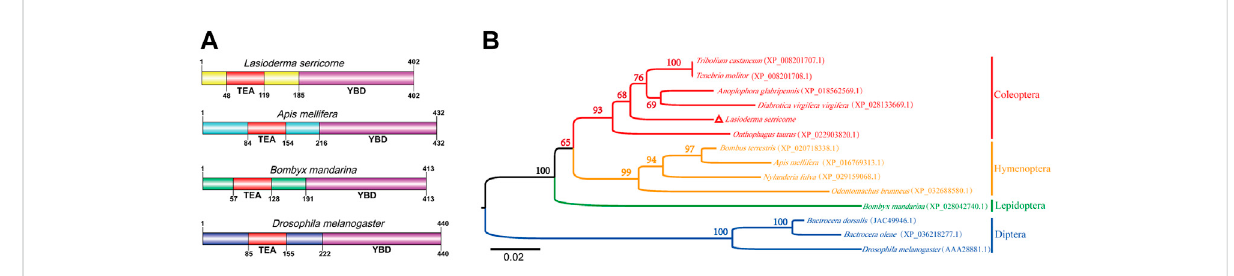
FIGURE 1 PhylogenetictreeandpredictedstructureoftheSdproteinsininsects. (A) Thededucedaminoacidsequenceswereusedtopredictthedomain of Sd proteins using SMART tool. (B) The phylogenetic tree of Sd protein was constructed by MEGA6 software using the neighbor-joining method with 1,000 bootstrap replications. Numbers at the branch nodes represent the level of bootstrap support for each